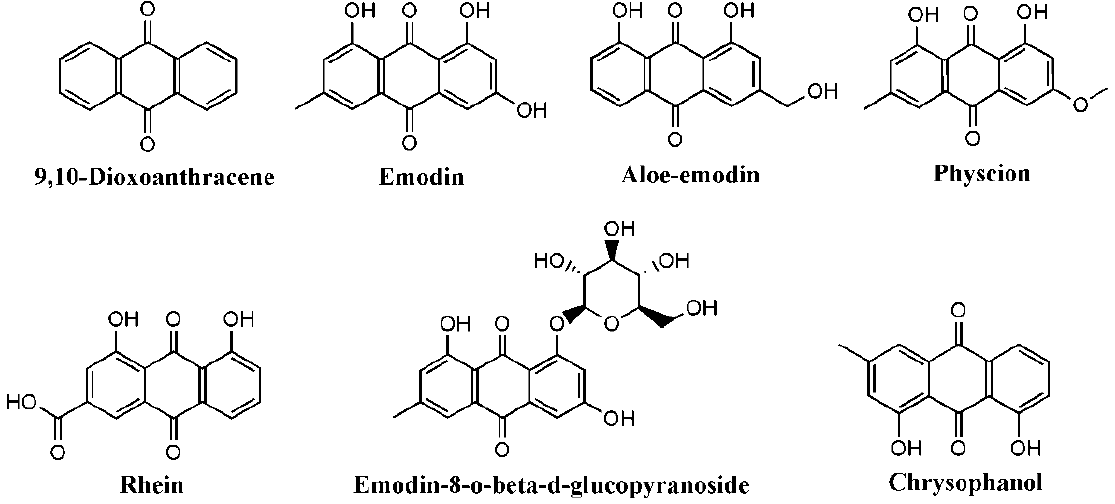
Figure 1. Chemical structure of AQs mentioned in this paper.